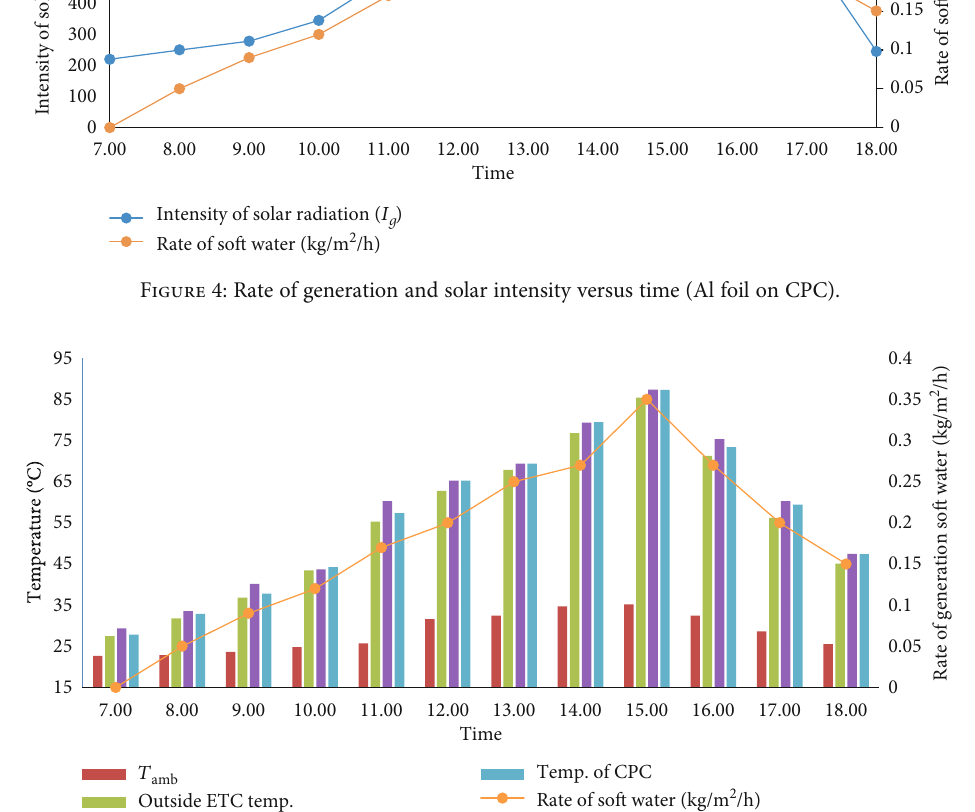
Figure 5: Variations of the rate of generation and measuring temperatures versus time (aluminum